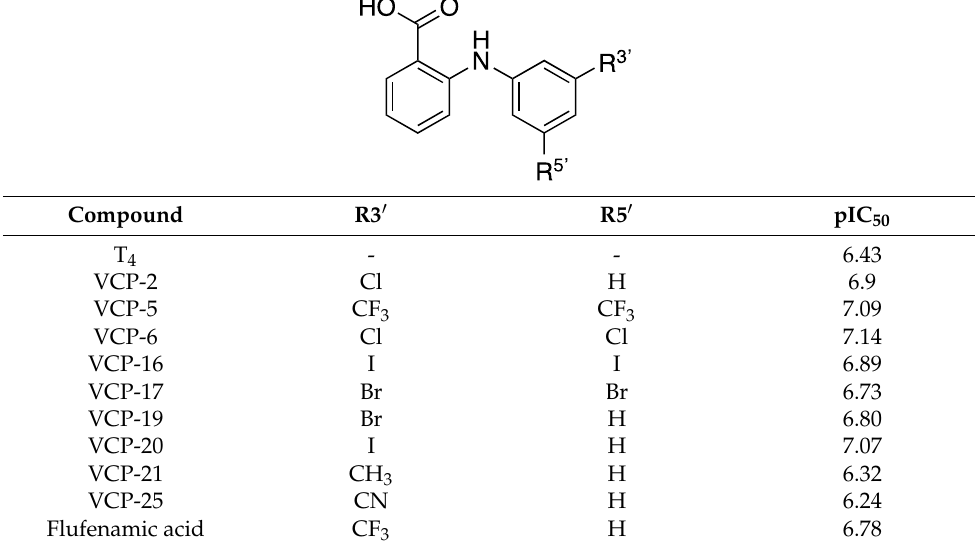
Figure 2. Structures of VCP-6 and tafamidis. Table 1. Affinities of a selection of phenylanthranilic acid derivatives for hTTR a